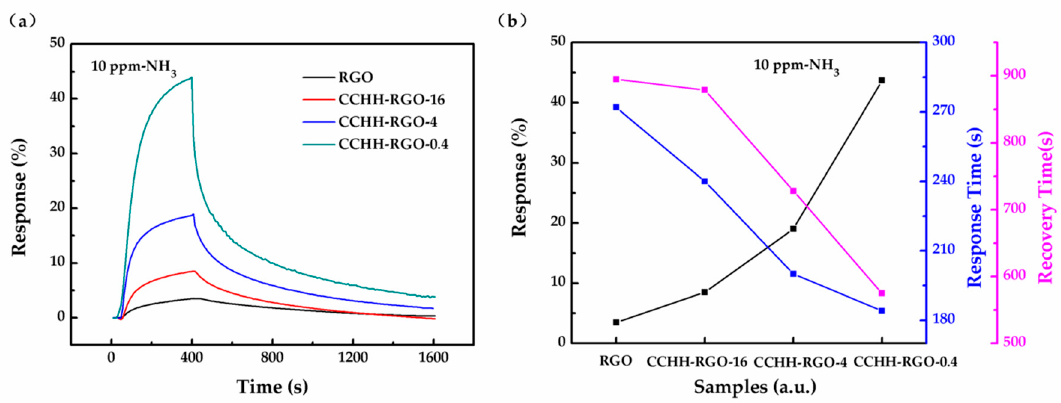
Figure 6. ( a ) Gas sensing response curve of four sensors to 10 ppm ammonia; ( b ) Gas sensing response, response time and recovery time of four sensors for 10 ppm ammonia.